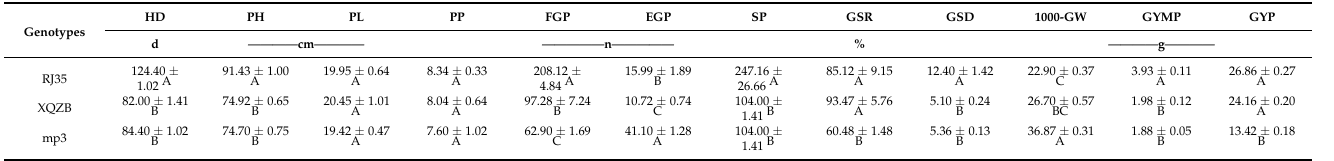
Figure 3. Plant morphology of XQZB and mutant mp3 at heading stage. ( A ) Plant morphology of mutant mp3. ( B ) Plant morphology of wild-type rice. ( C ) Panicle of wild type. ( D ) Panicle of mutant mp3. Table 1. Agronomic traits of mutant mp3 and wild-type rice.